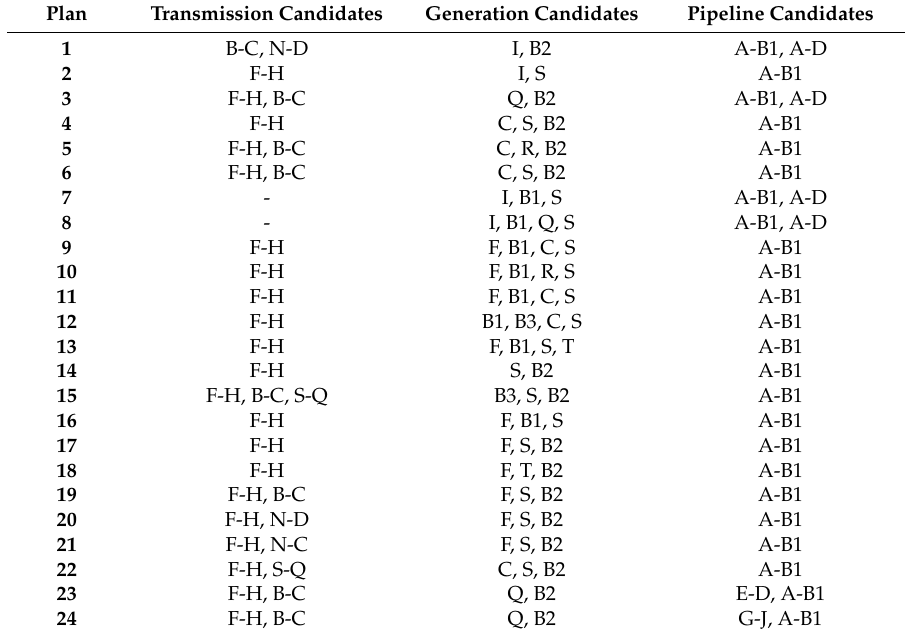
Table 3. Alternatives considered for expansion planning of gas and electricity networks.